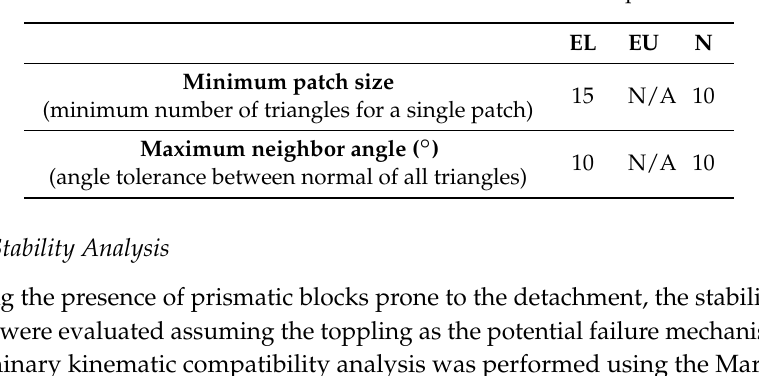
Table 2. Parameters set for the automatic identification of